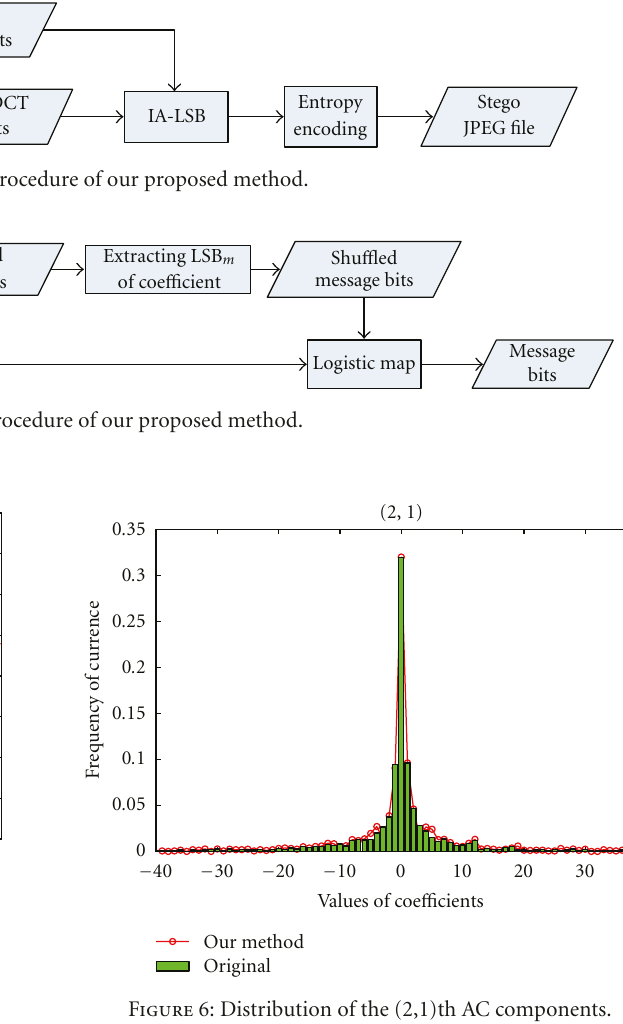
Figure 5: PSNR of our method, F5, and MB1.